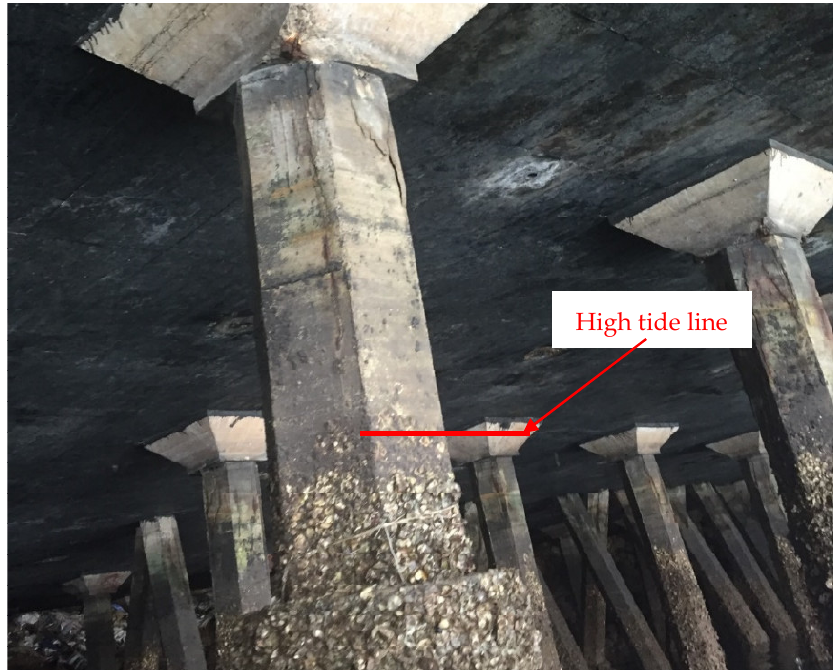
Figure 4. Steel corrosion damage on concrete piles above the high-tide line in the splash and spray zone: concrete berth on the Southern African east coast (age: ca. 50 years).